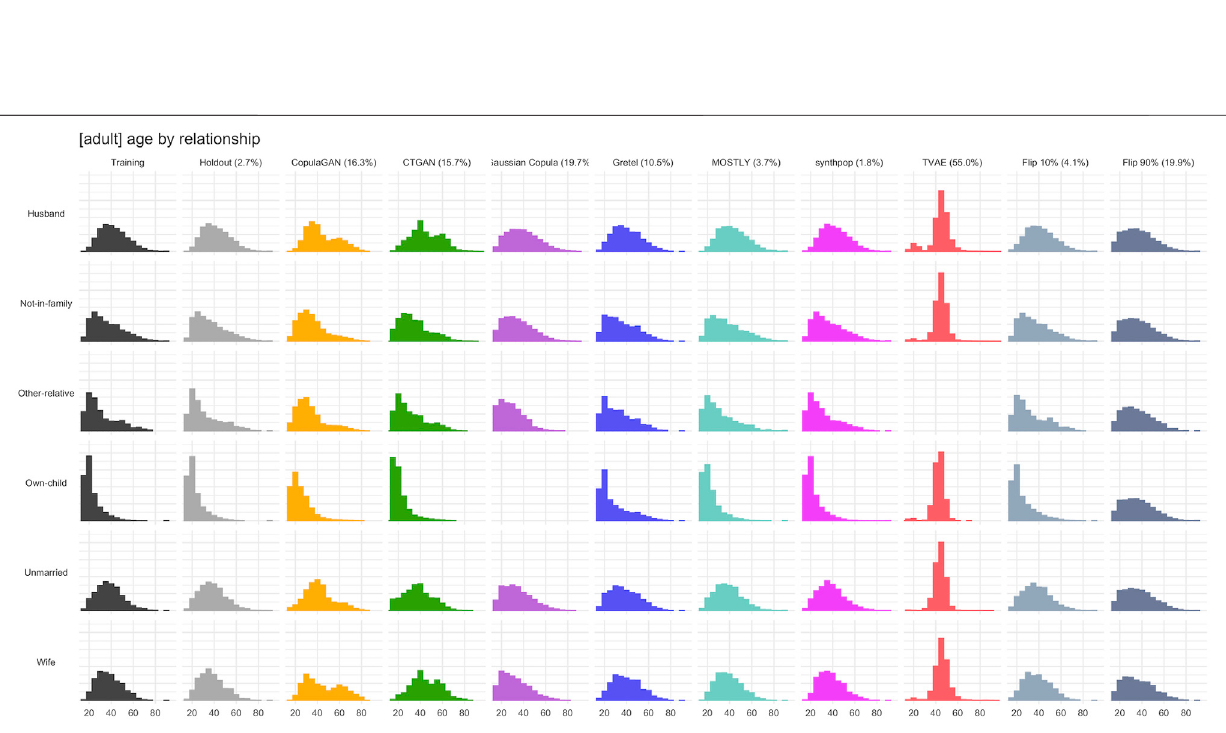
Frontiers in Big Data |